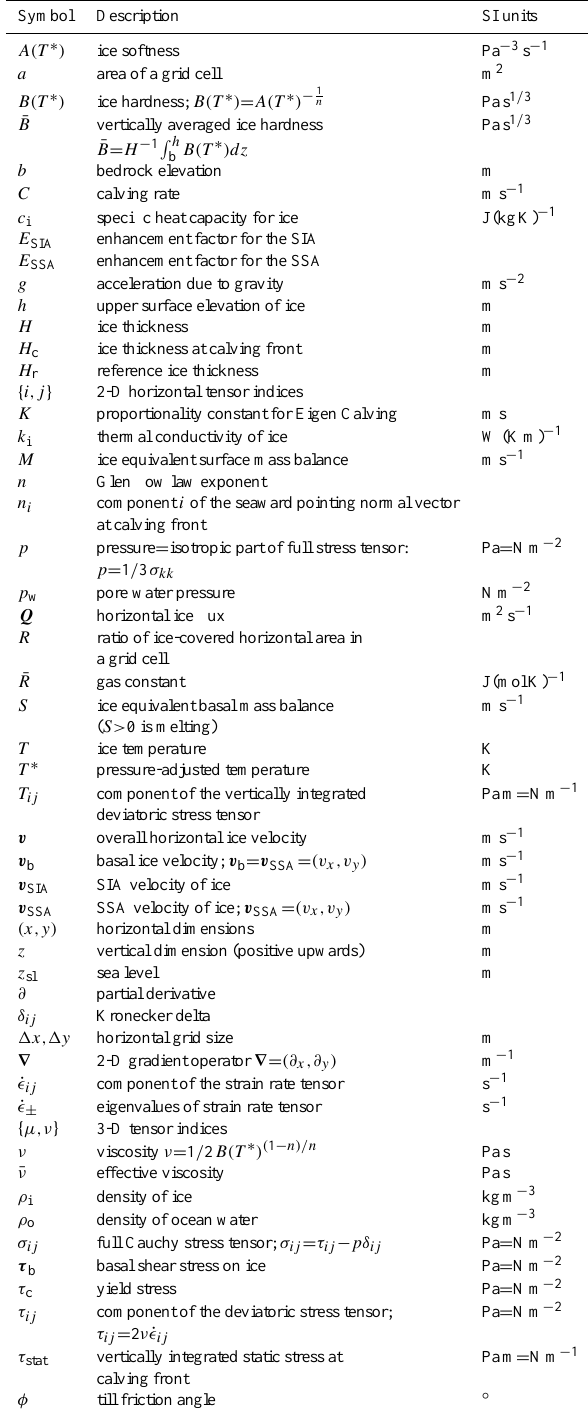
Table A1. Table of